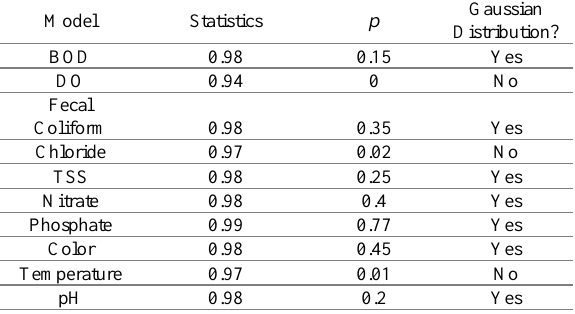
Table 2 . Shapiro-Wilk results for water quality models Results shown in Table 2 indicate that all models except DO, chloride, and temperature have normal residual distribution. Residuals for DO and temperature is skewed towards the right, while a bimodal distribution is present in the residuals for Chloride. A potential cause for this is that some of the predictors are significantly non-normal, which might affect the confidence intervals for these three models. Table 3 summarizes the results for the following tests: Linear Relationship between the Target and the Feature (Appendix A), Little to no multicollinearity among predictors (Appendix B), Autocorrelation, and Homoscedasticity of Error